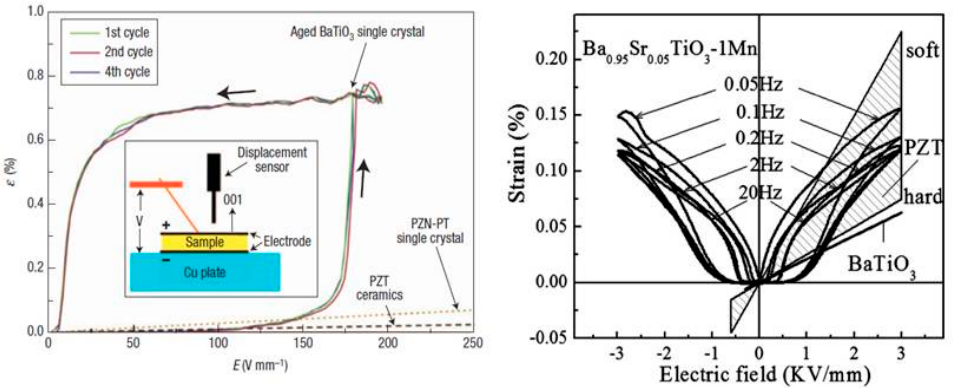
Figure 5. The non-linear electrostrain in aged point-defect-doped BaTiO 3 single crystal ( left ) and ceramics ( right ) [40,41].